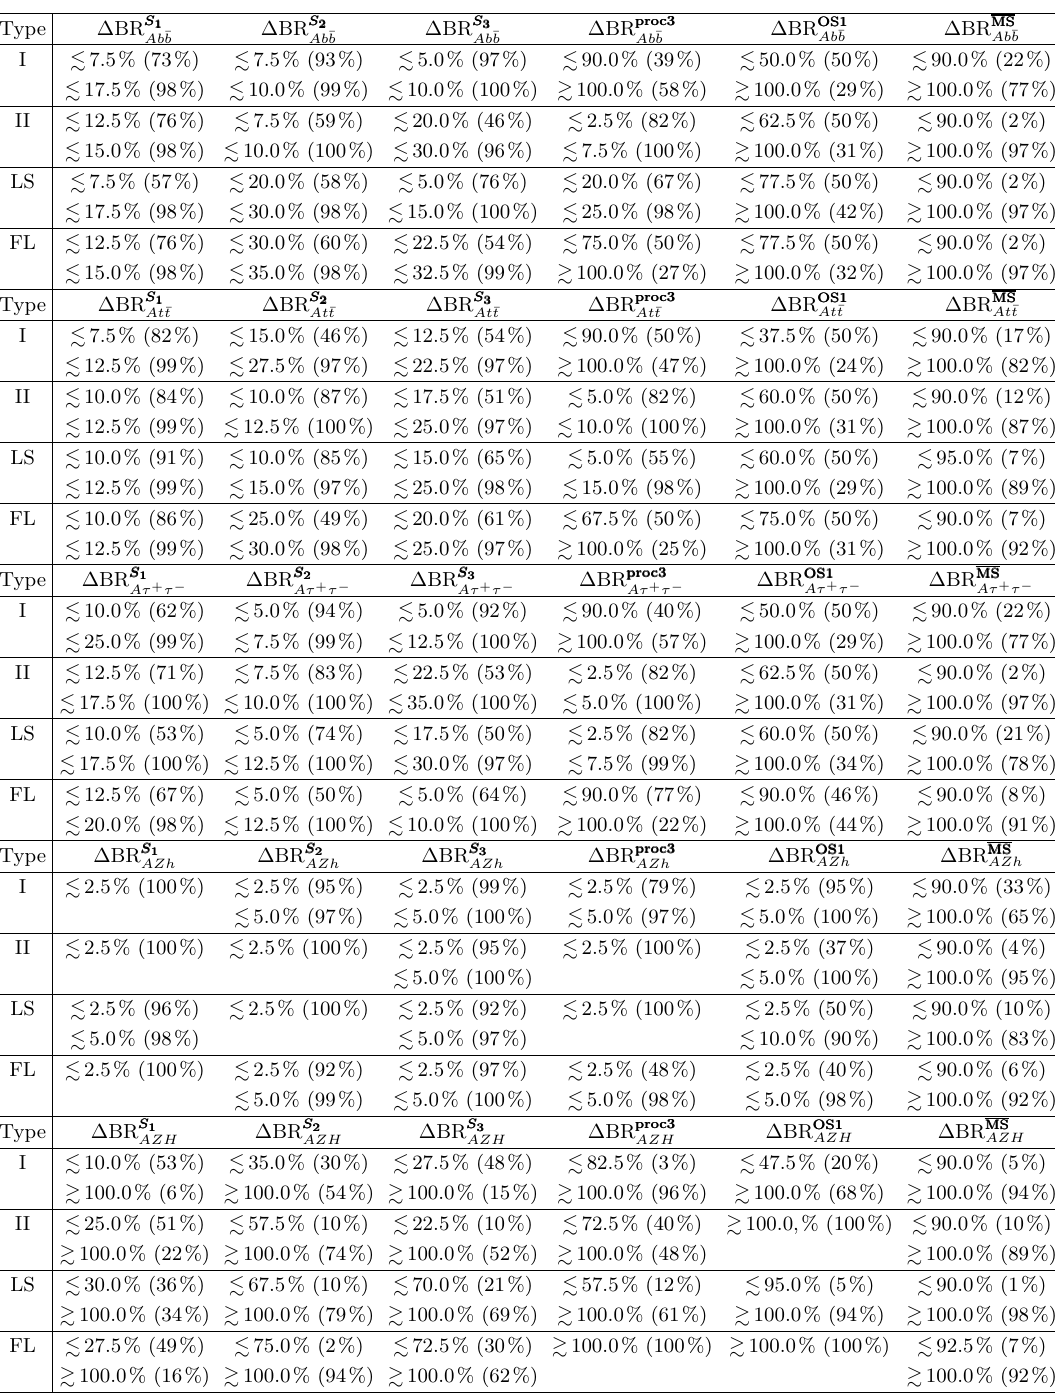
Table 15 . Relative size of the EW corrections to the BRs for the pseudoscalar 2HDM Higgs boson A decays into b (cid:22) b , (cid:28) + (cid:28) (cid:0) , t (cid:22) t , Zh , and ZH , in the four 2HDM types I, II, LS and FL ( H is SM-like).